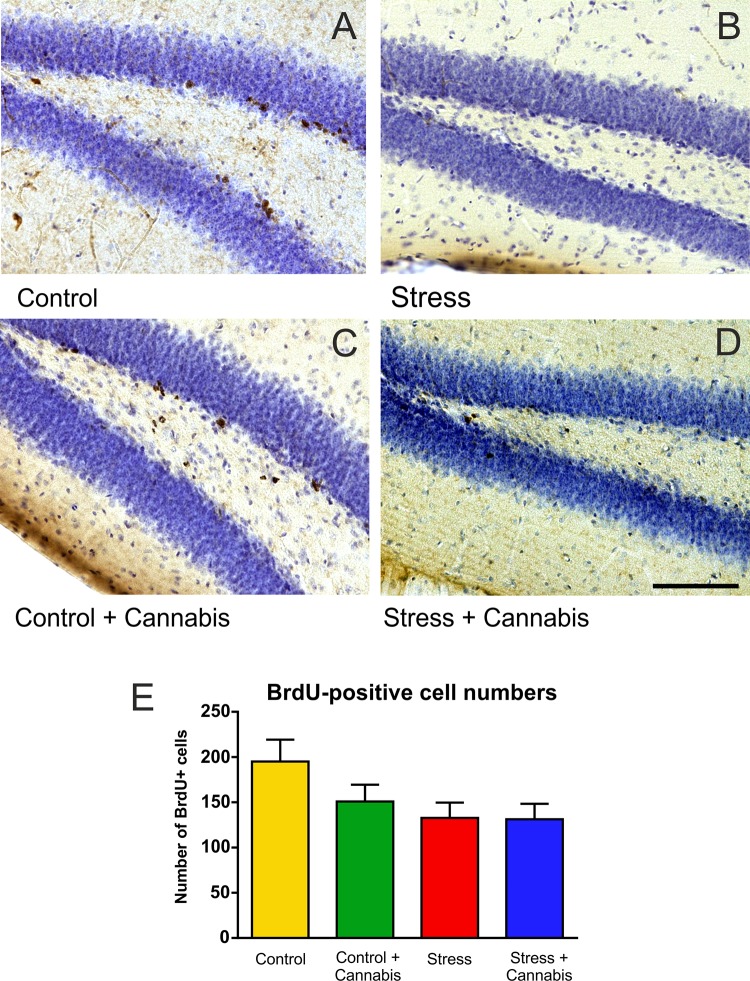
Stress inhibited progenitor cell proliferation in the dentate gyrus. Representative images demonstrating BrdU-immunohistochemistry labeling in the dentate gyrus of the animals from the different treatment groups (A–D). (E) The total number of BrdU-positive cells in the dentate gyrus of one hemisphere. Stress significantly reduced the number of BrdU-positive cells in the dentate gyrus. Two-way ANOVA (stress × cannabis treatment) revealed a significant main effect of stress (P < 0.05), but cannabis treatment had no statistically significant effect on cell proliferation. Scale bar: 100 μm for all images.